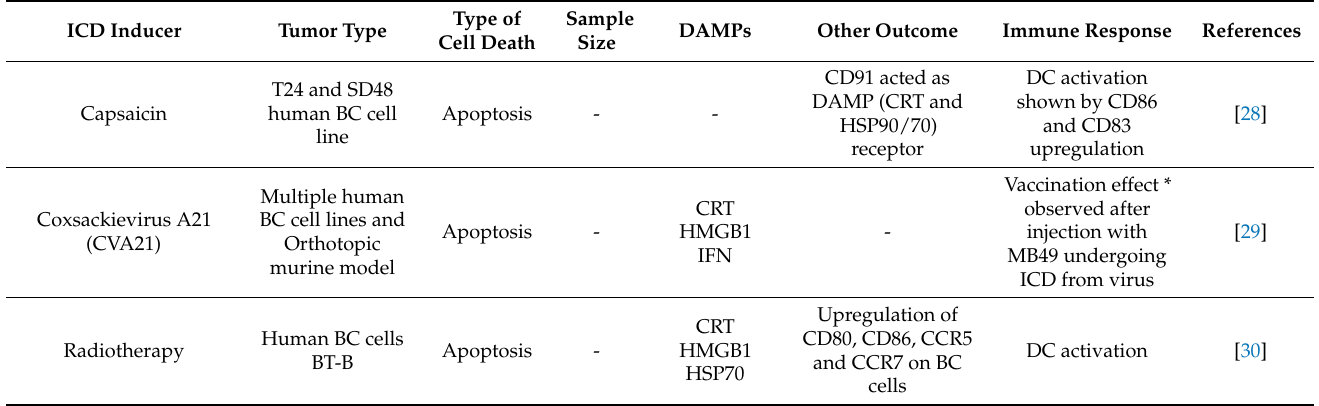
Figure 1. Process of identification and inclusion of studies. PRISMA Flow diagram. Table 1. Overview of main ICD inducers based on their immunogenicity and DAMP response-mediated. * Vaccination effect: Rejection of tumor cells in animal models after their immune system is exposed to cancerous cell compounds is called anti-cancer vaccination effect.